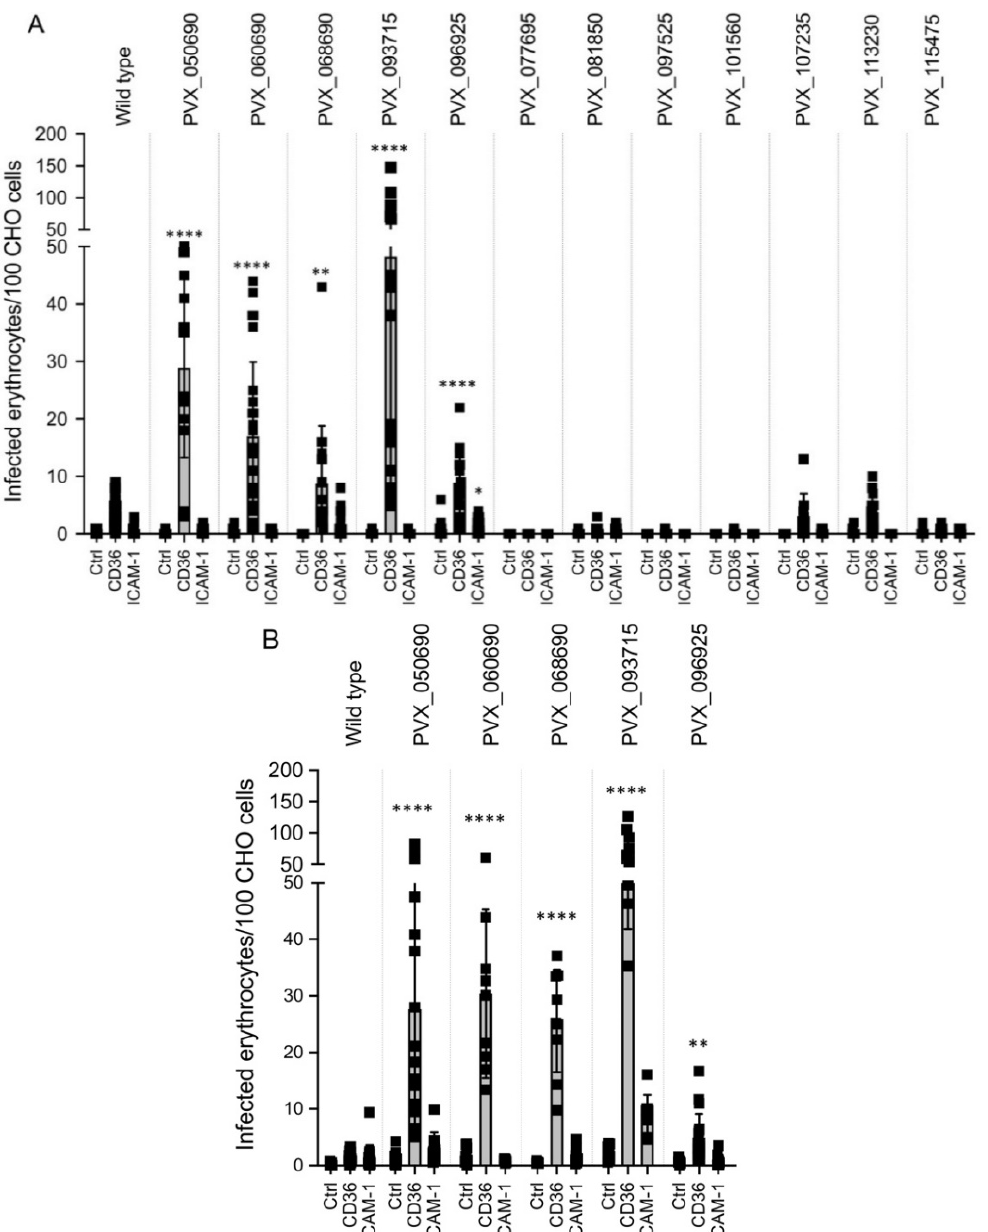
Figure 4. Binding ability of erythrocytes infected with 3D7 (wild type) and 3D7 transfectants ( vir - expressing) to transgenic CHO-745 cells presenting CD36 and ICAM-1, respectively. ( A ) Binding of trophozoite stage Pf IEs to mock (ctrl), CD36-, and ICAM-1-presenting CHO-745 cells. ( B ) Binding of schizont stage Pf IEs to mock (ctrl), CD36-, and ICAM-1-presenting CHO-745 cells. The experiments were performed at least three times, and the number of bound Pf IEs per 300 CHO-745 cells was determined. Thus, between 9 to 63 coverslips were evaluated per experiment. The unpaired t test was used to investigate the statistical significance of the binding of Pf IEs to mock-transfected CHO-745 cells (Ctrl) and transgenic CHO-745 cells presenting CD36 or ICAM-1 on their surfaces. (* p < 0.05, ** p < 0.01, **** p < 0.0001).